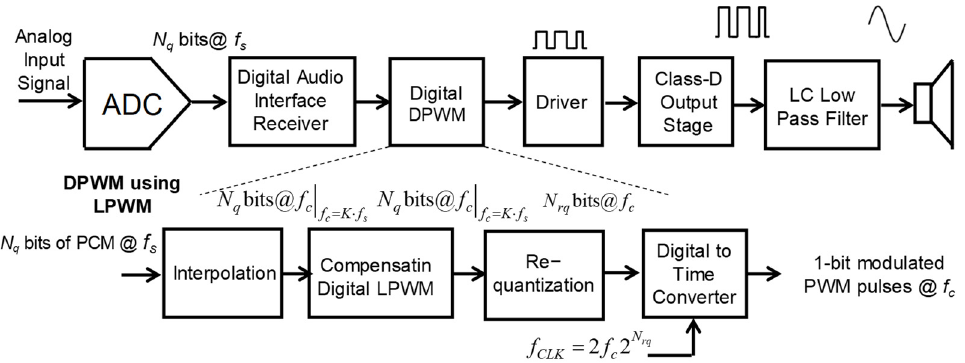
Figure 1. Block diagram of an open-loop digital Class-D amplifier.